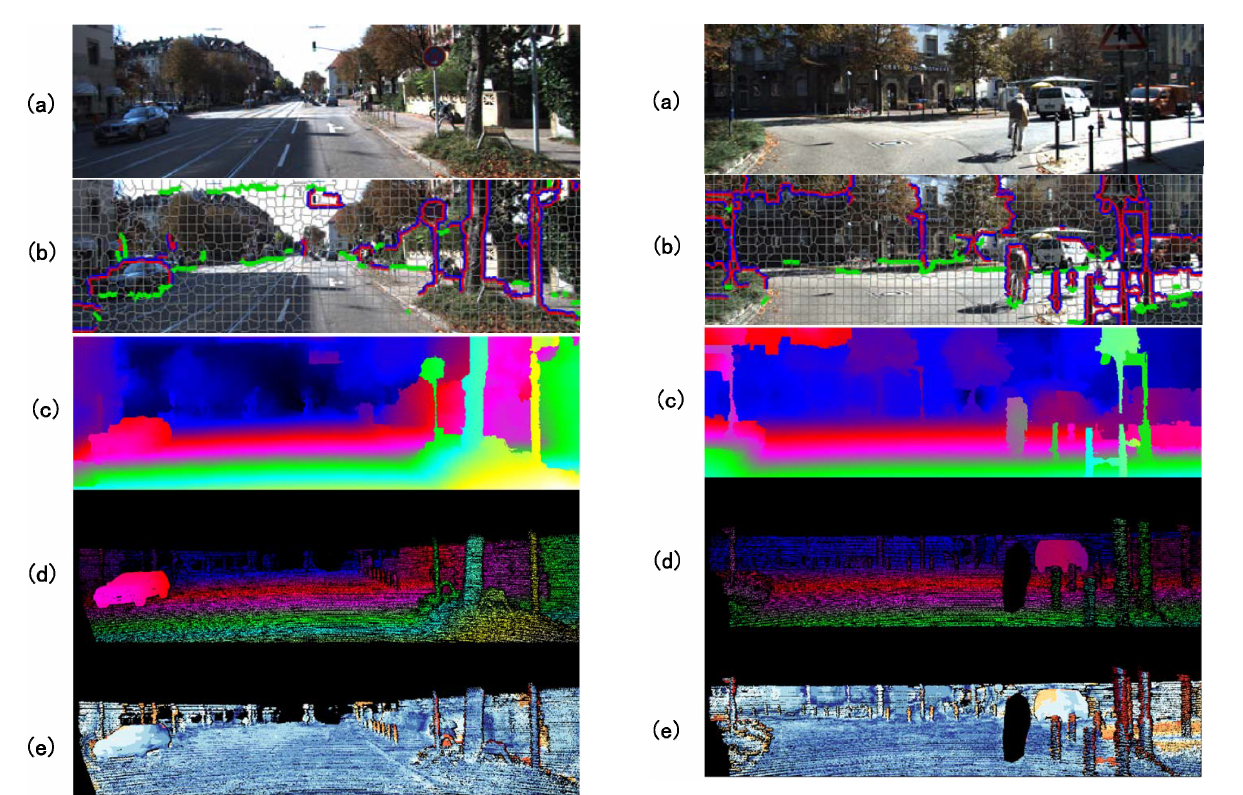
Figure 8. Qualitative results of our improved slanted plane model. (a) Left image; (b) Segments and boundaries; (c) Disparity map; (d) Ground truth; (e) Error graph